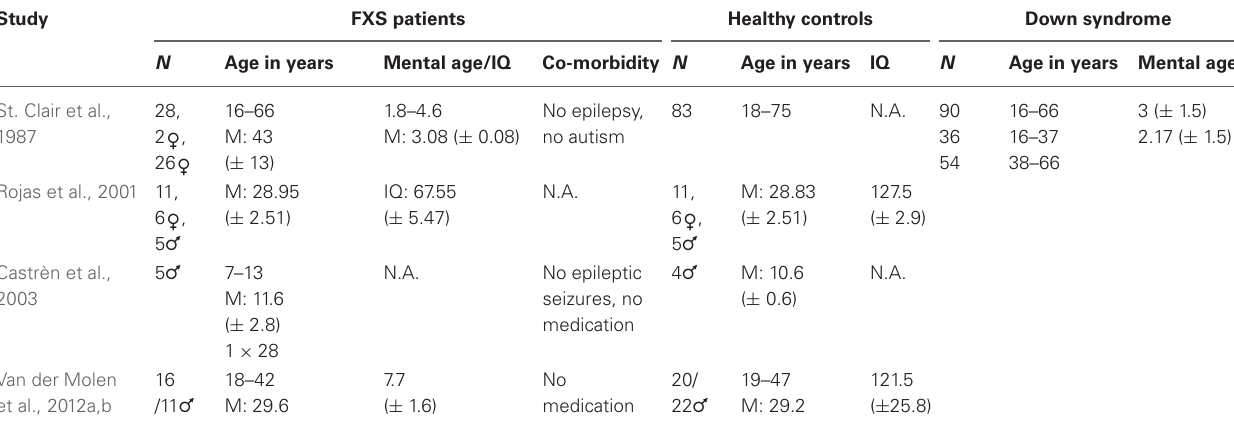
Table 2 | Study population characteristics in the reviewed